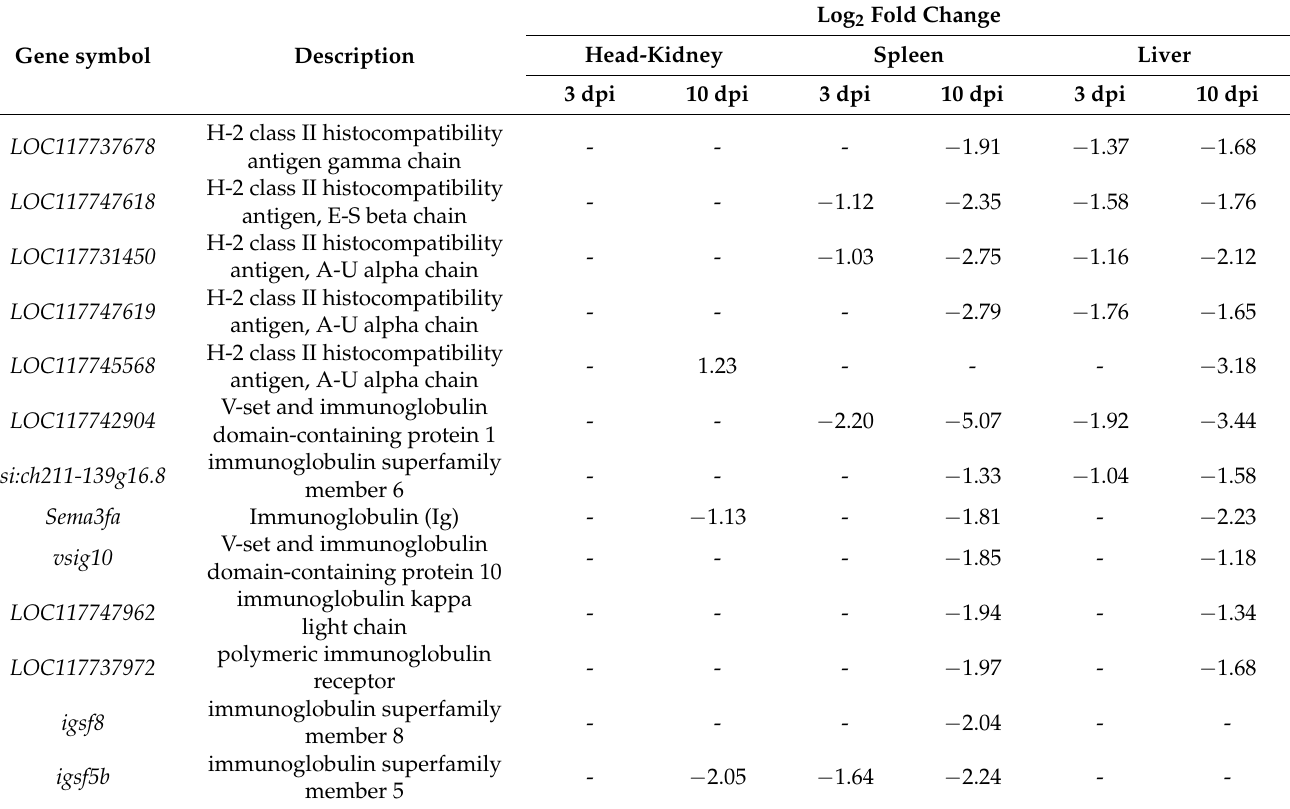
Figure 10. Most significant DEGs in the liver after A. salmonicida infection in lumpfish. Bar plots represent the expression pattern (log 2 TPM) of adenosine receptor A3 (adora3), carcinoembryonic antigen-related cell adhesion molecule 1 (ceacam1), DNA damage-inducible transcript 4 protein (ddit4), DNA replication ATP-dependent helicase/nuclease DNA2 (dna2), and DNA mismatch repair protein Msh2 (msh2) . Furthermore, we observed significant downregulation of genes encoding MHCII and IgM in all analyzed organs (Table 4). In addition, cd79a , cd79b , and cd209 were downregu- lated in the head-kidney, spleen, and liver (Table 4). Table 4. Significant differential regulation of adaptive immune marker (log 2 FC ≥ 1, FDR ≤